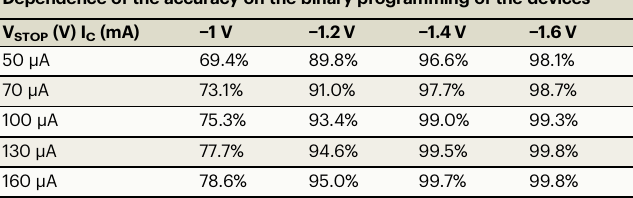
Table 1 | Accuracy of the network for fi nding the escape path starting from a fi xed initial point Dependence of the accuracy on the binary programming of the devices V STOP (V) I C